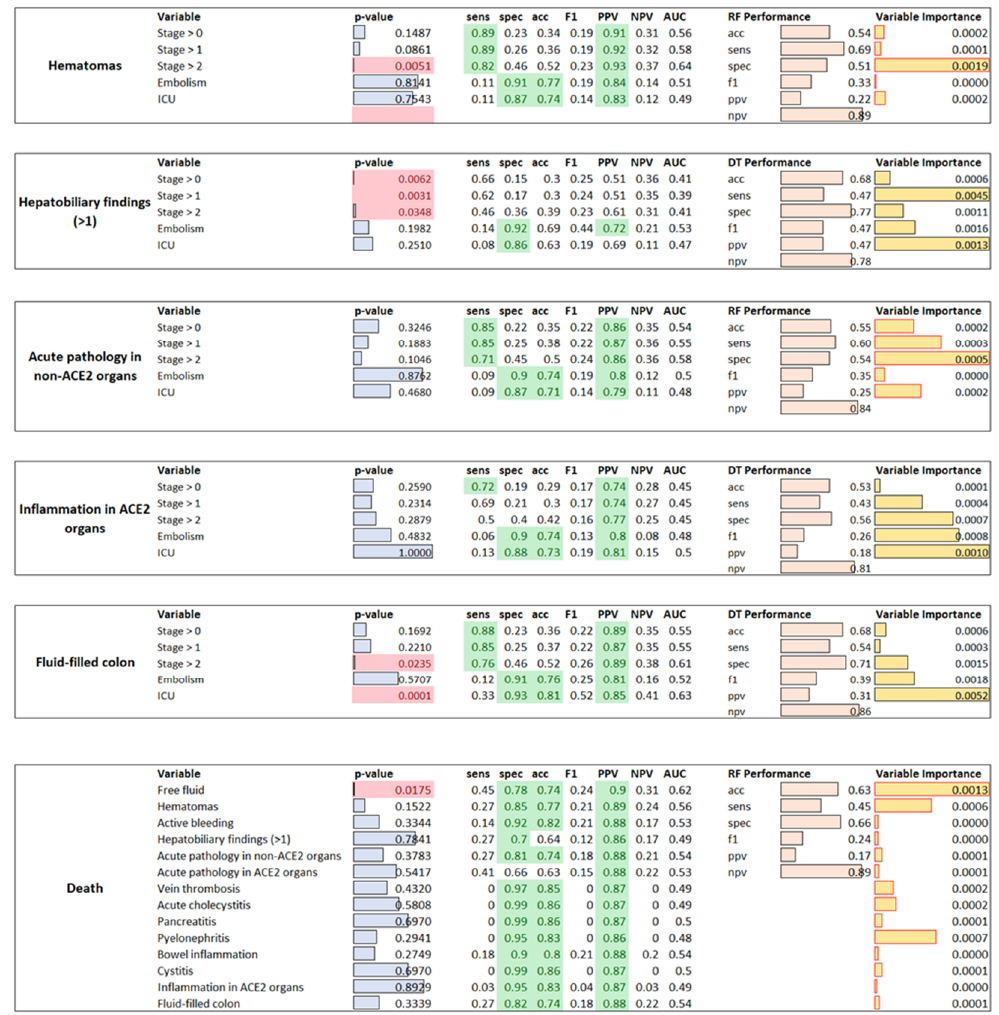
Figure 3. For each variable to be predicted, each sub-table reports the p -values obtained by univariate statistical analysis (red color highlights significant variables— p -value <0.05), by the individual predictor variable performance, where green cells highlight good performance (>0.7), the performance of the best classifier model (RF or DT) and the variable importance in prediction.